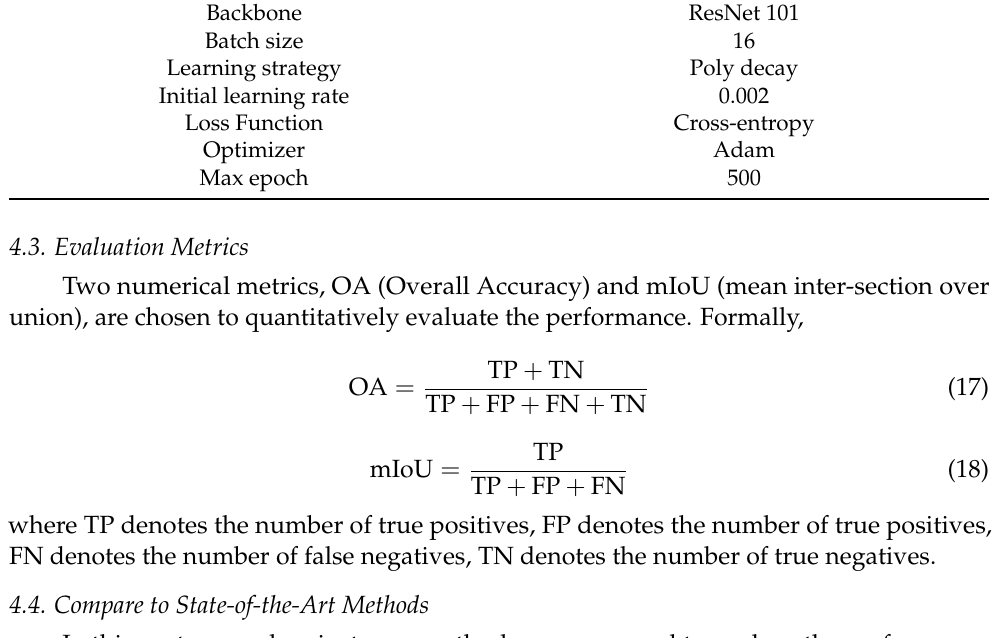
Table 2. Hyper-parameter settings.